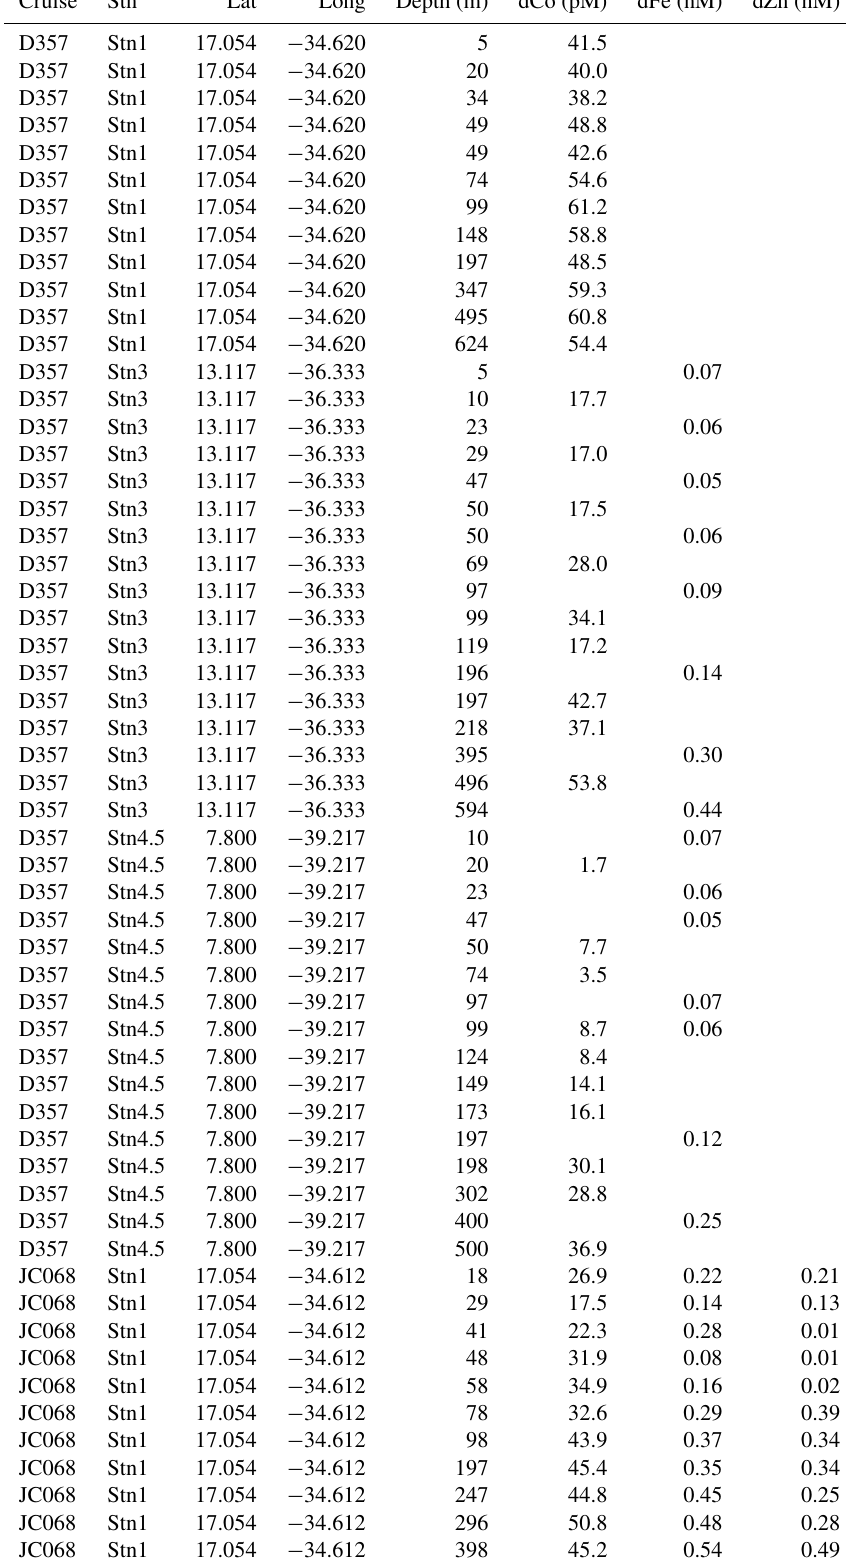
Table B2. Upper ocean ( < 600m) dTE